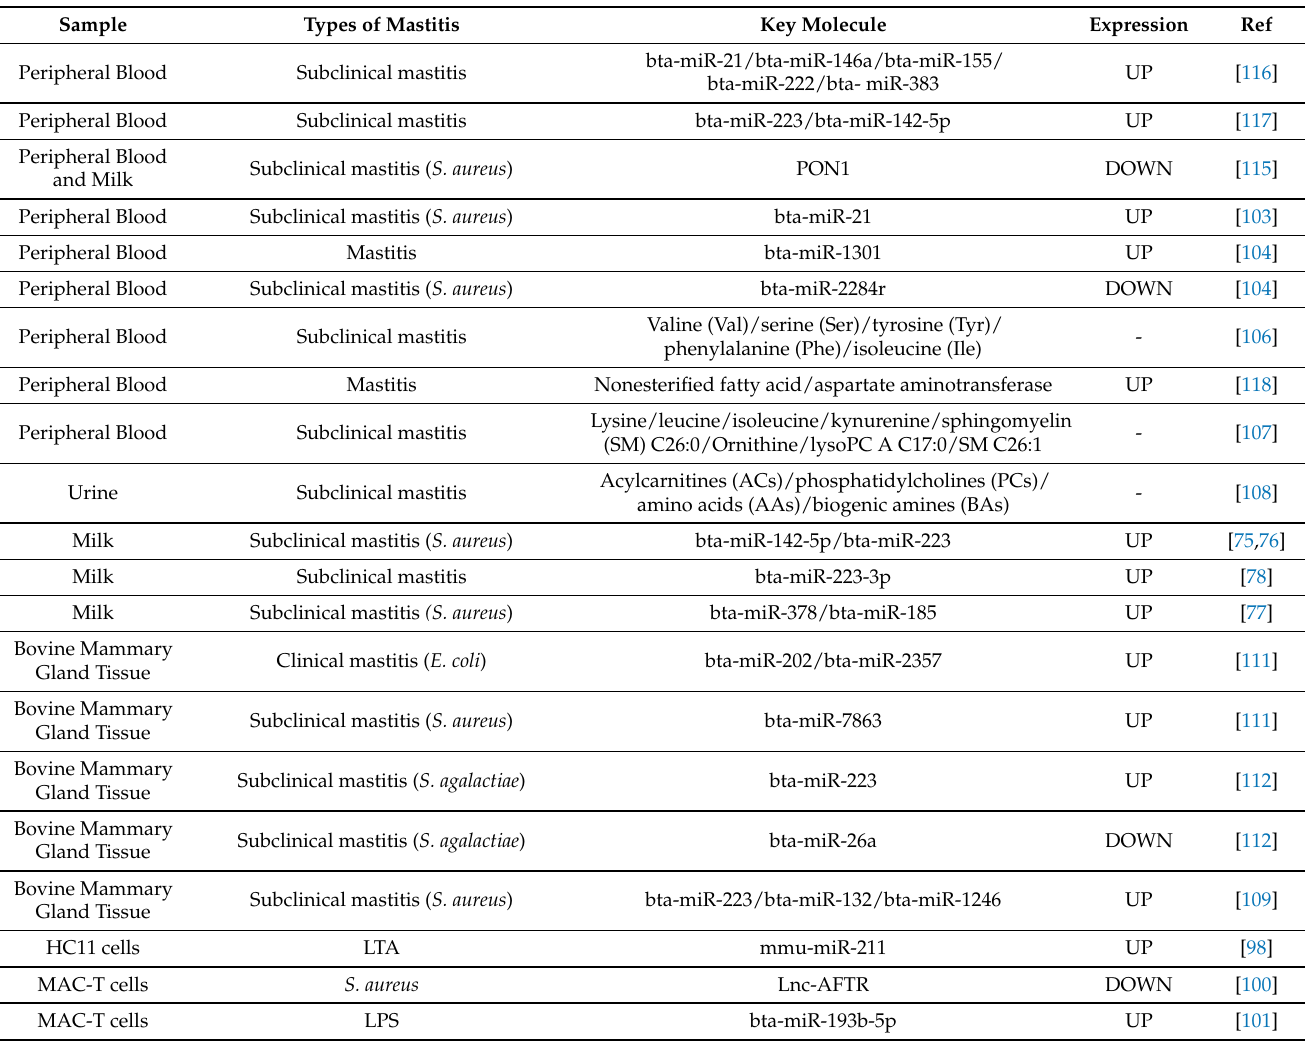
Table 2. Potential Biomarkers in